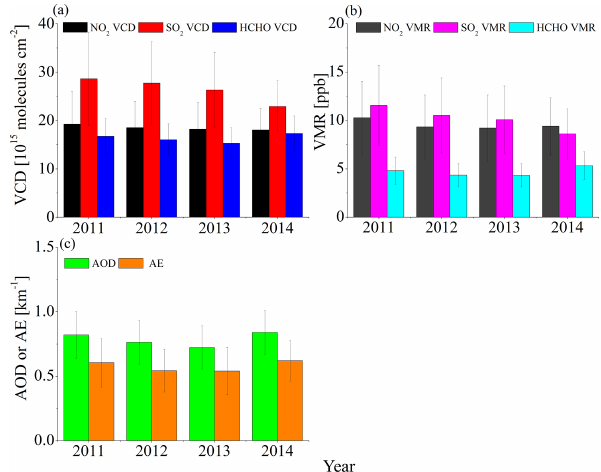
Figure 12. Mean (May to November) VCDs (a) and near-surface VMRs (b) of NO 2 , SO 2 , HCHO as well as AODs and near-surface aerosol extinctions (c) for each